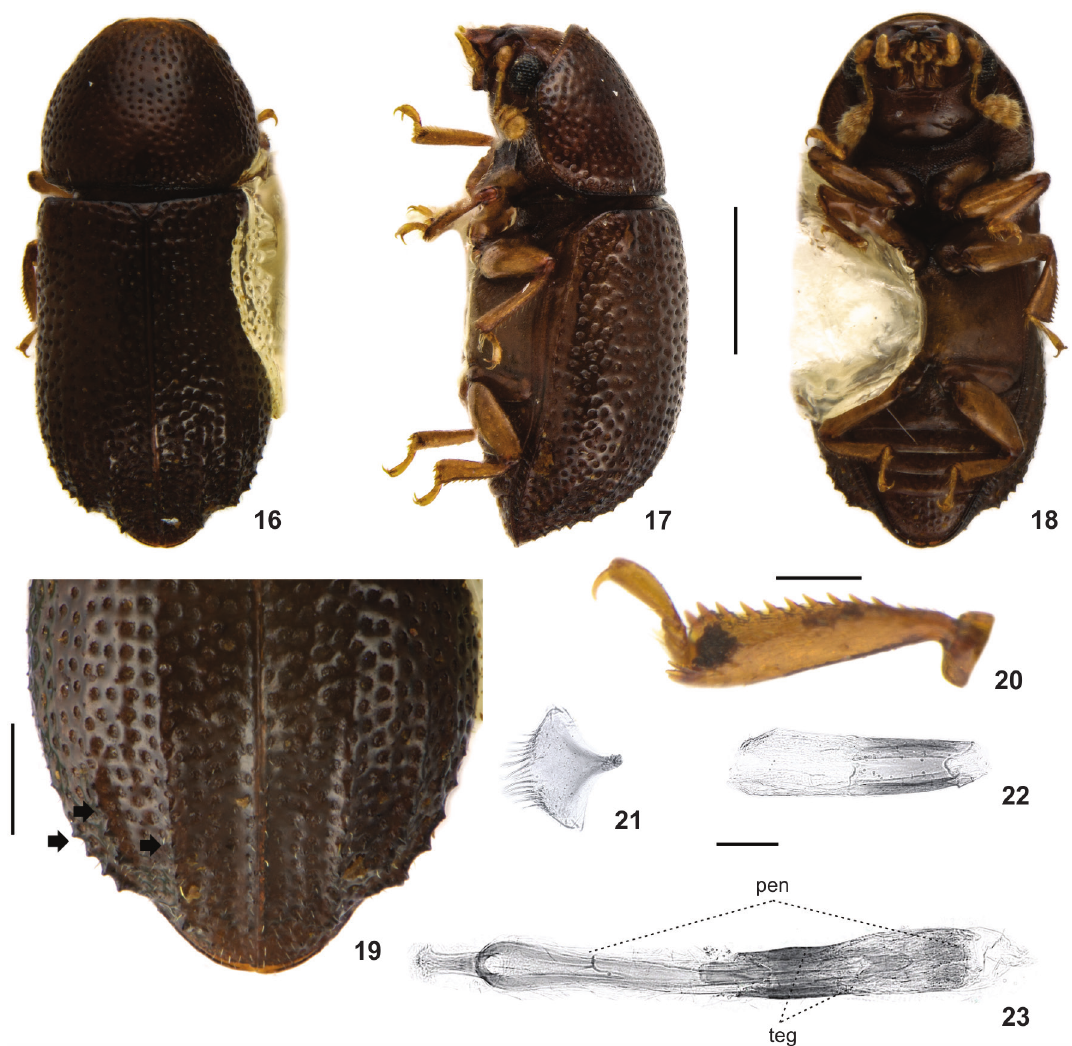
Figures 16–23. Holotype of Xylographella frithae sp. n. from Queensland, Australia: (16) dorsal view; (17) lateral view; (18) ventral view; (19) apical declivity of elytra; (20) left metatibia. Dissected male terminalia of paratypes: (21) sternite VIII; (22) tegmen; (23) aedeagus showing tegmen (teg) and penis (pen). Scale bars: 0.5 mm (16–8); 0.2 mm (19); 0.1 mm